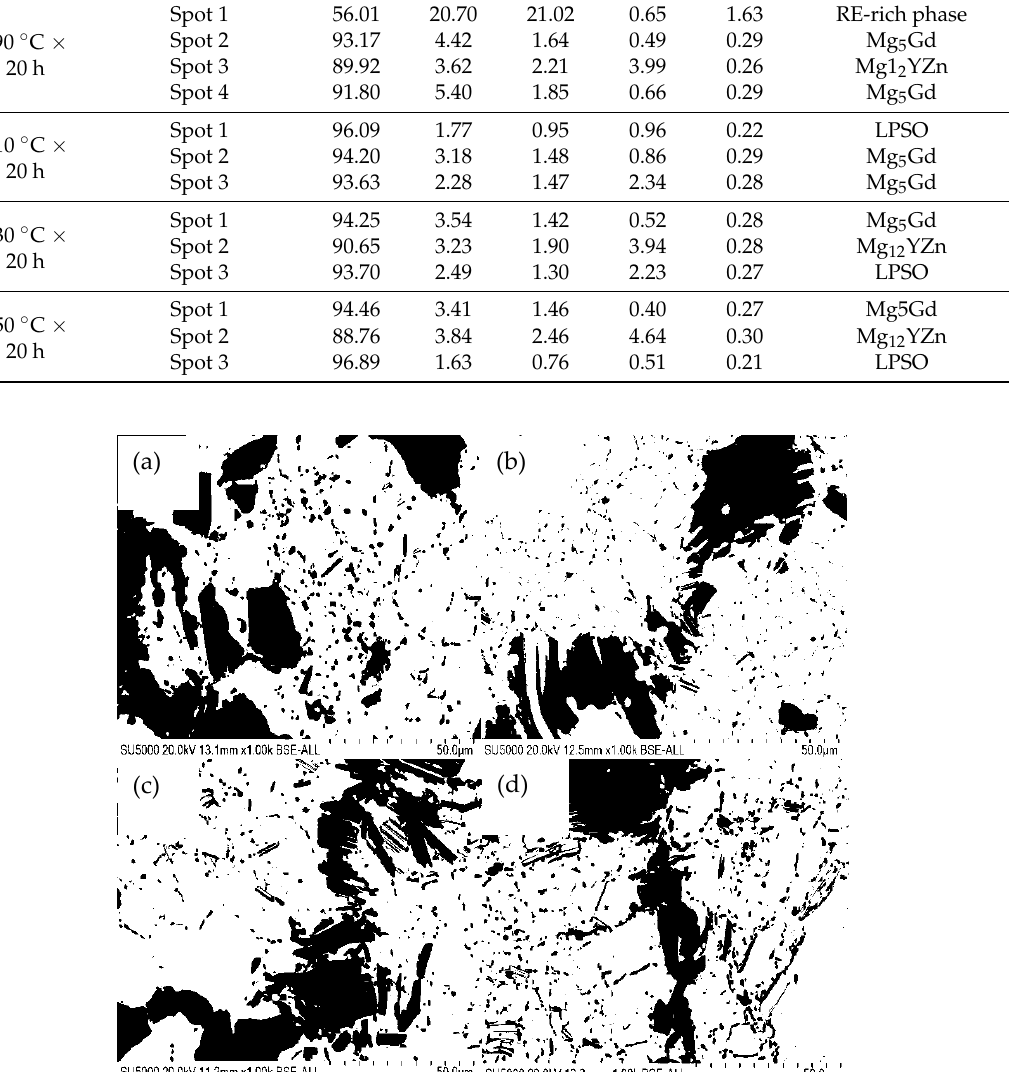
Figure 9. ImageJ software processing diagram for alloys subjected to different ageing treatments. ( a )